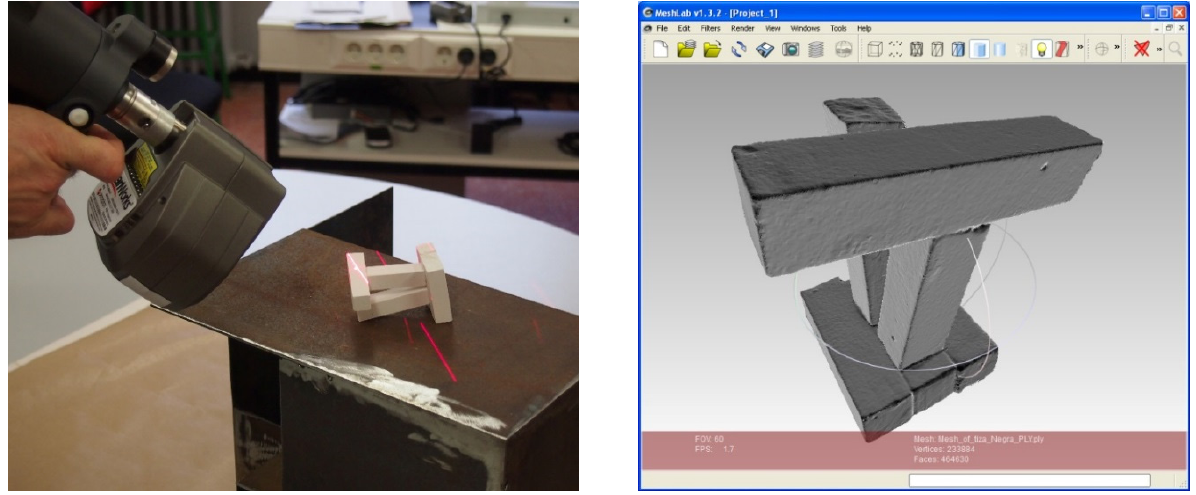
Figure 5: Left: laser beam plane projected onto a piece for three-dimensional reconstruction. Right: mesh obtained from 3D point cloud.